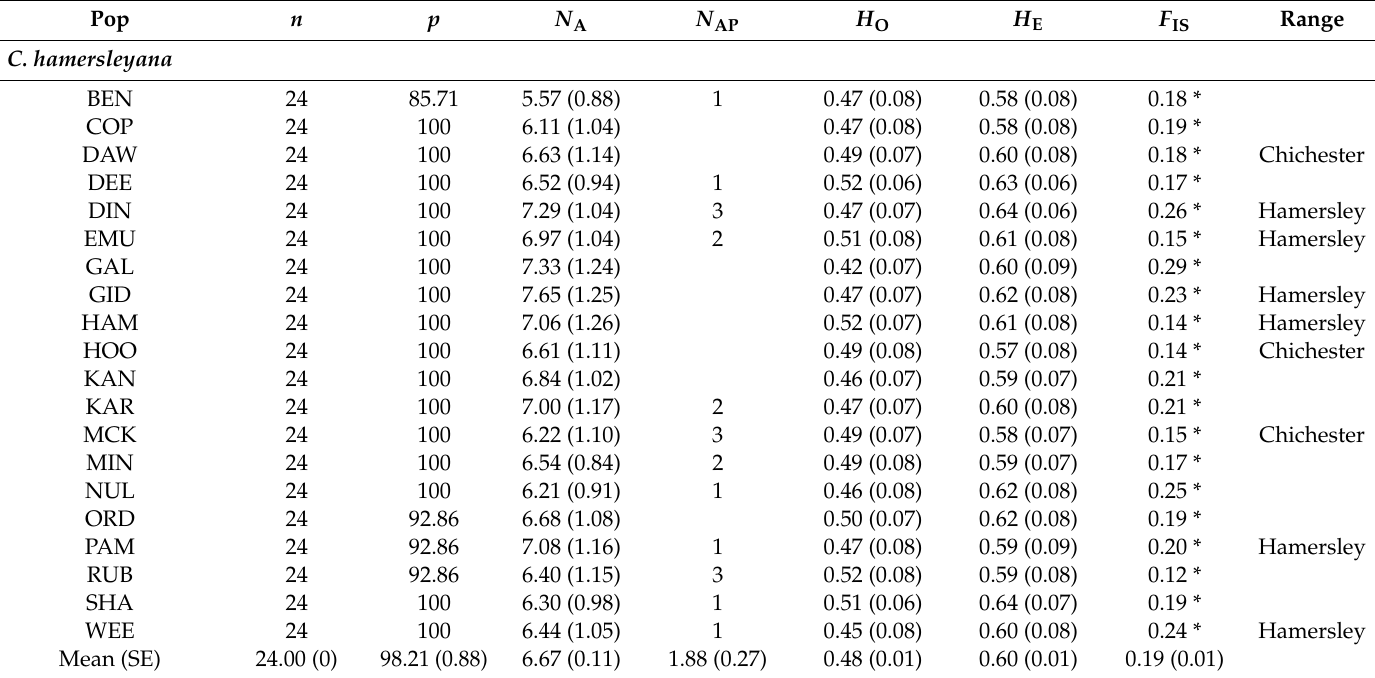
Table 1. Genetic diversity parameters for 20 populations of C. hamersleyana and 23 populations of A. pruinocarpa across the Pilbara region of north-western Australia. All parameters (except the total number of private alleles) are averaged across 14 nuclear microsatellite loci for each population. Standard errors are shown in parentheses. Presence on either Chichester or Hamersley Range is